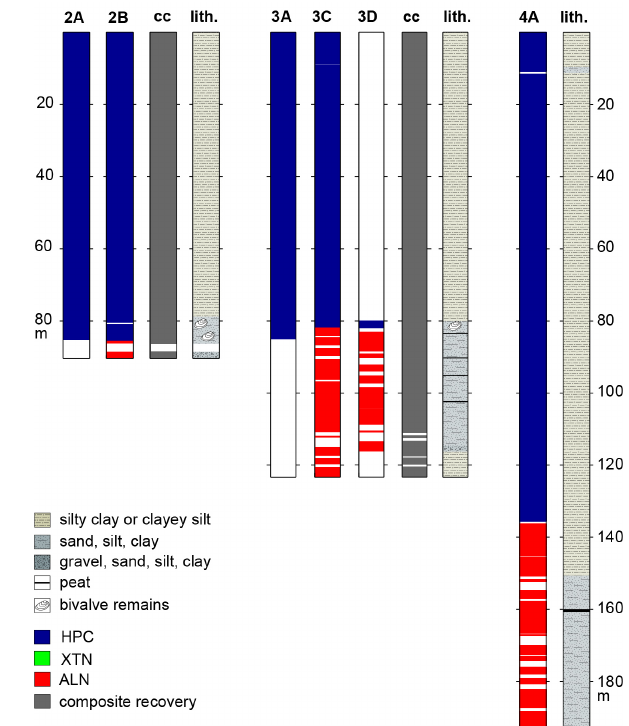
Figure 6. Core recovery and lithology from Cerava (2A and 2B), Gradište (3A, 3C, and 3D), and Peštani (4A) sites. Colours indicate di ff erent coring tools used (cf. Fig. 5). White sections in the core composites (cc) of each site indicate no core